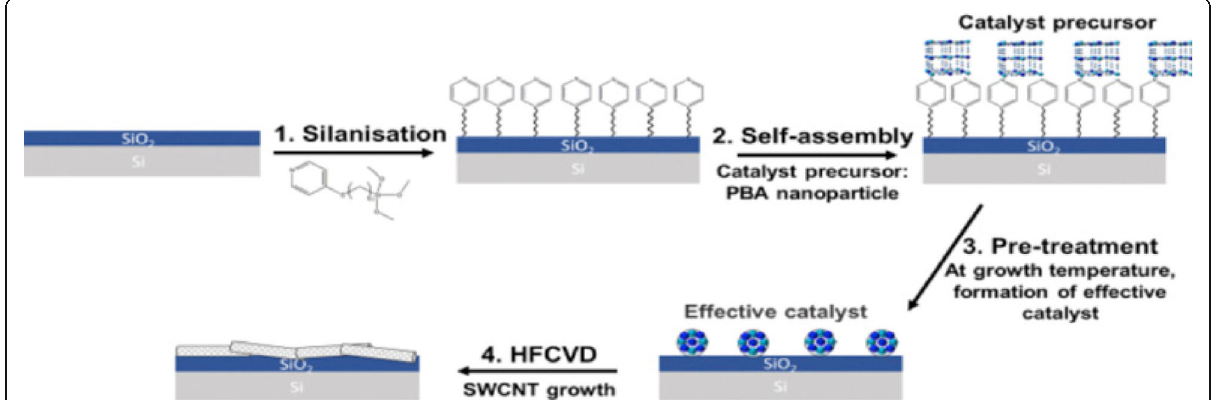
Fig. 24 Schematic of the steps followed in the methane CVD growth of SWCNT using PBA-based bimetallic nanoparticle catalysts. In this technique, SWCNTs with diameters in the range of 0.7 nm to 2.6 nm were grown on silicon substrates coated with an oxide layer onto which self-assembled silane molecules were deposited. Adapted from [188]